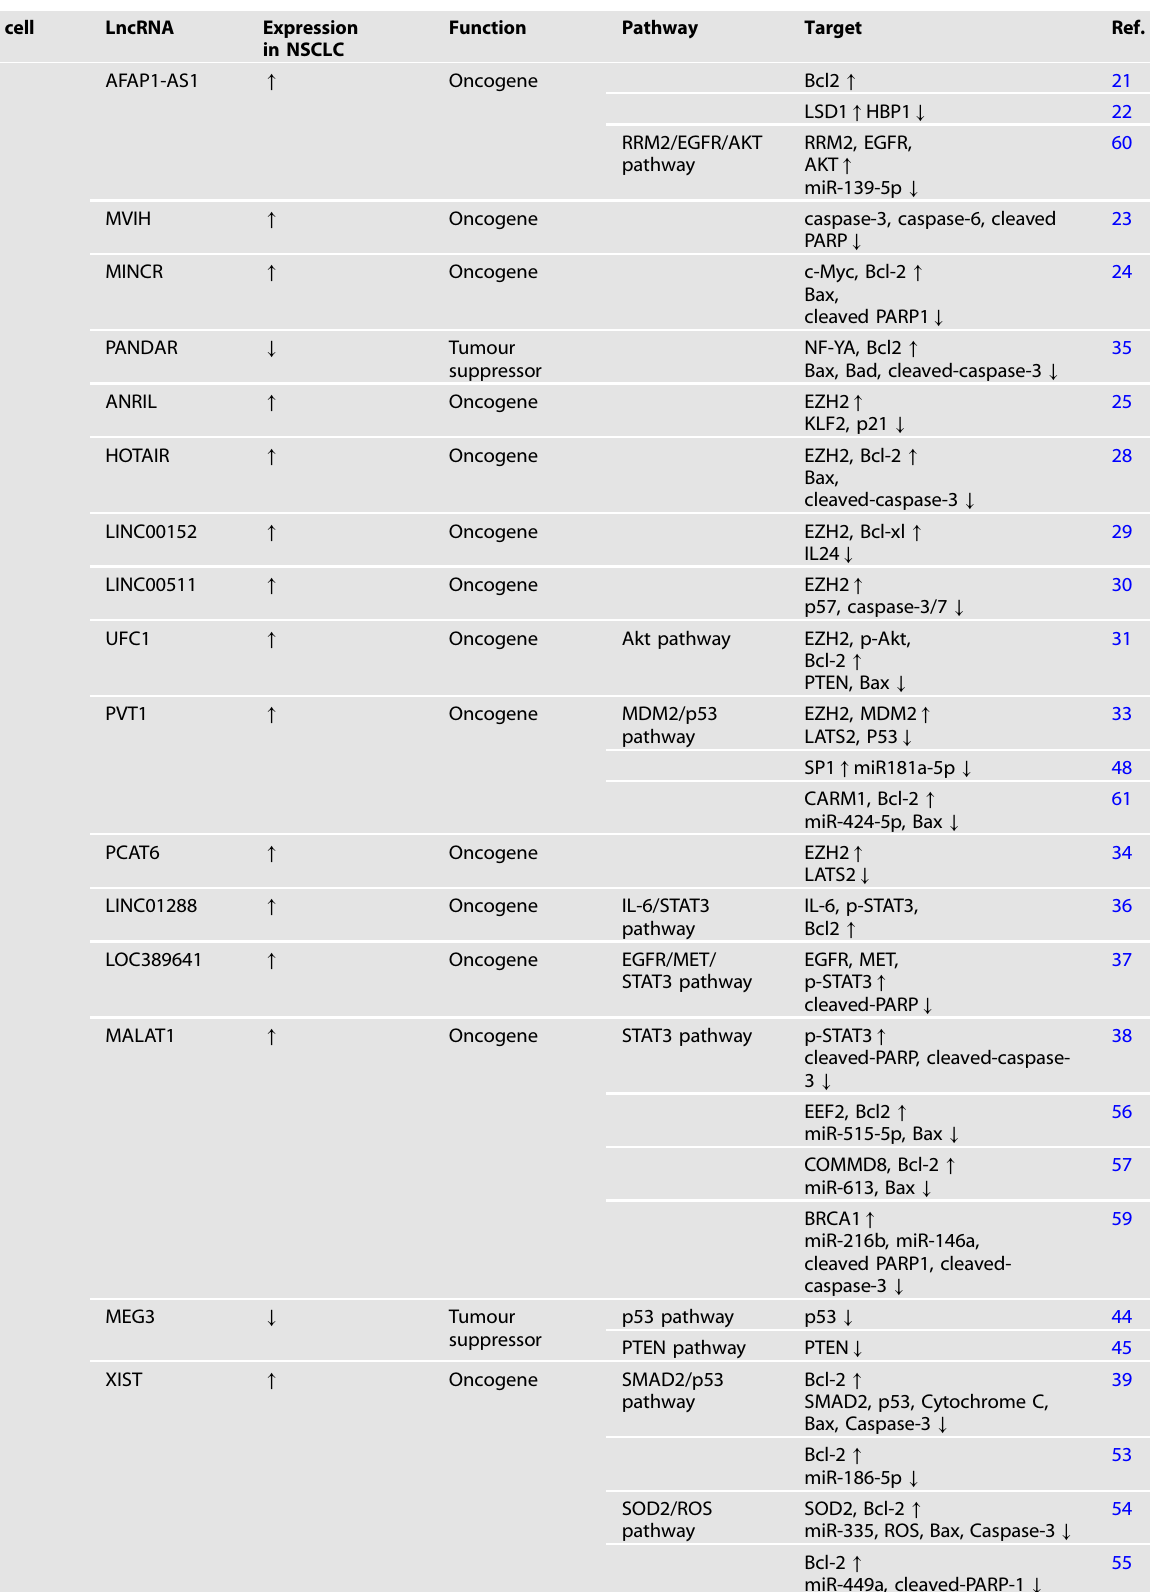
Table 1. Effects of lncRNAs on PCD in